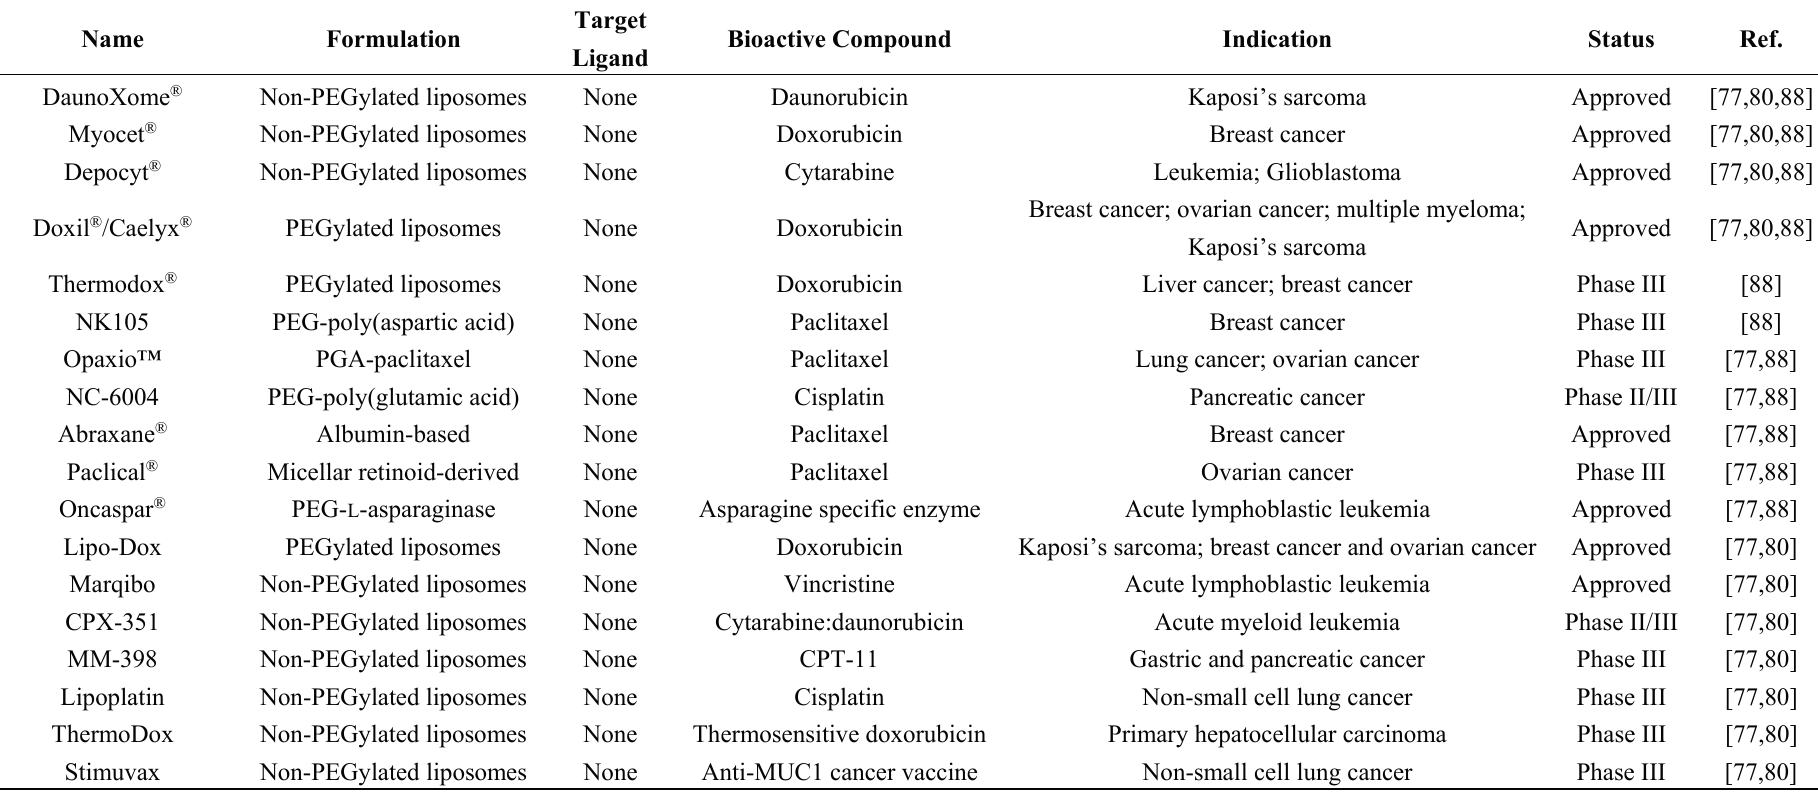
Table 2. Nanoscale drug delivery devices, FDA approved or in different phases of clinical trials by which the bioactive compounds mentioned herein are heterocyclic in